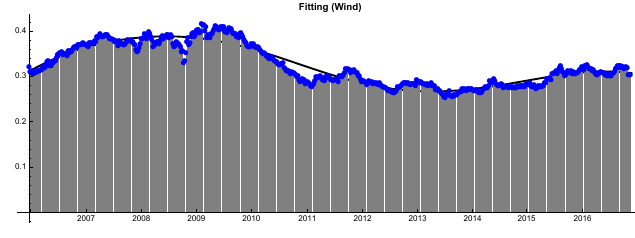
Figure 2. Fitting of WIND between 2006 and 2016 using a Fourier